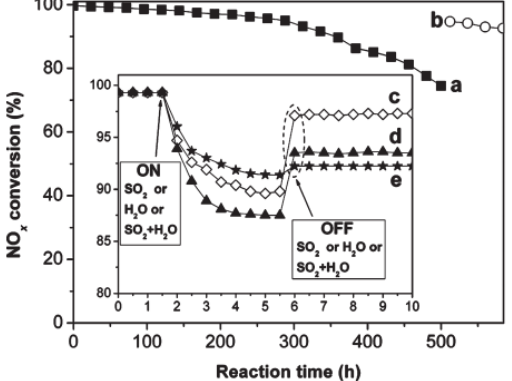
Figure 8. Lifetime, SO 2 tolerance, and water resistance of Fe ‐ (0.4)MnO x (CA ‐ 500) catalyst (Reaction